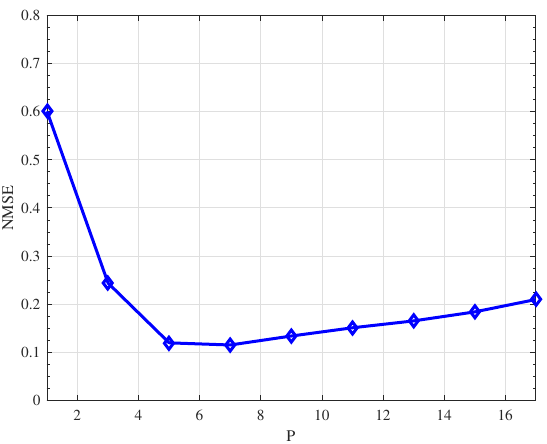
Figure 7. NMSE comparison versus parameter P